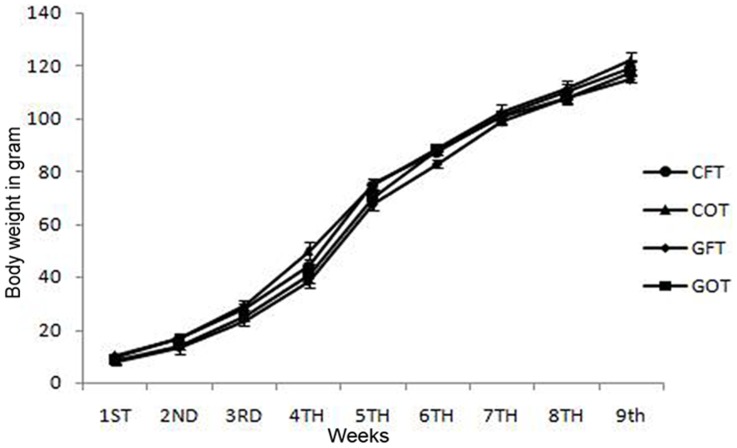
Postnatal growth rates.Comparison of postnatal growth rates between control rats transplanted with neonatal ovary (COT) or a wedge of fat (CFT) and GalTase-ab-exposed rats transplanted with neonatal ovary (GOT) or wedge of fat (GFT). All the groups exhibited comparable increase in their body weight till 9th post-natal week. Each point represents the mean value of at least 5 rats in each group.